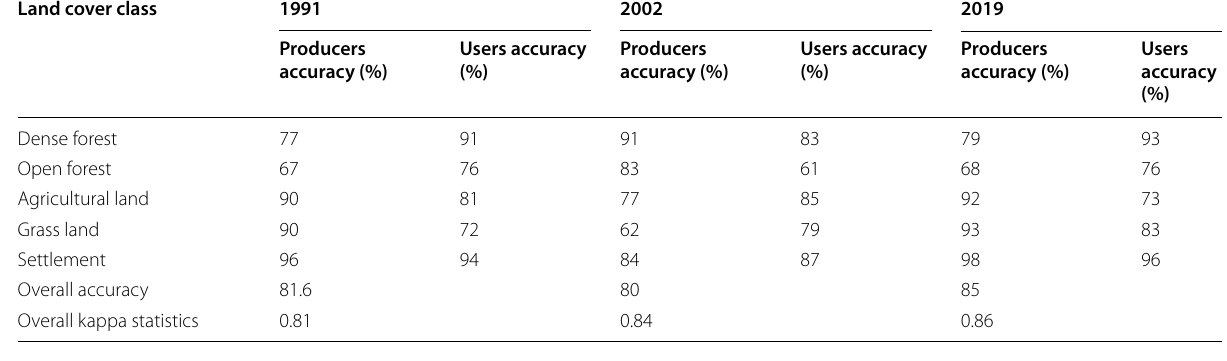
Table 5 Accuracy assessments for 1991, 2002 and 2019 Land cover class